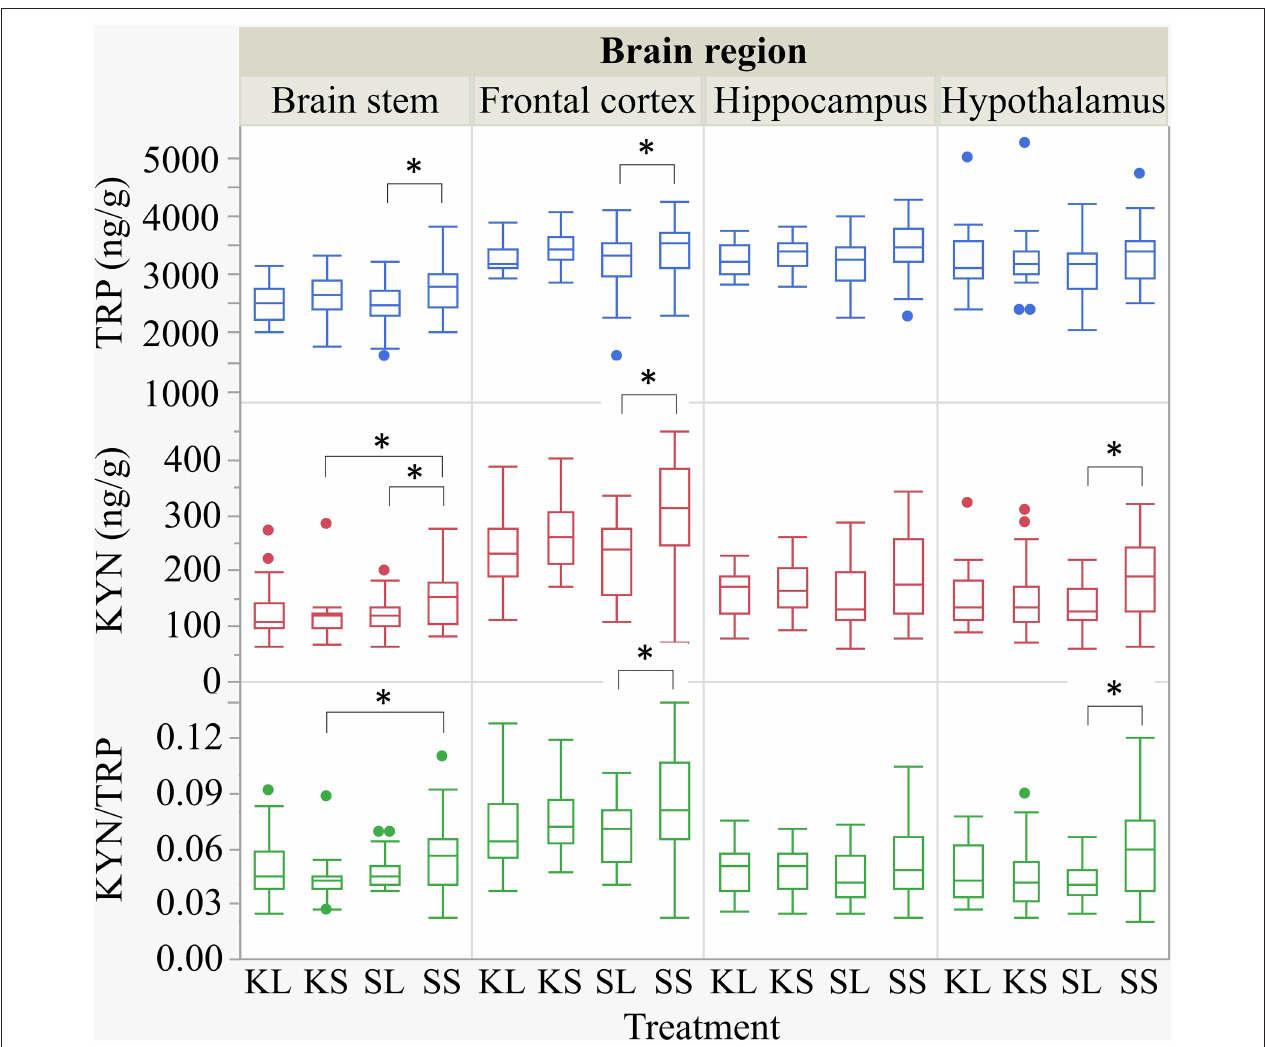
milligram of the respective analyte. Round dots indicate outliers. Significant differences of planned comparisons between treatments ( p < 0.05) are marked with an asterisk.